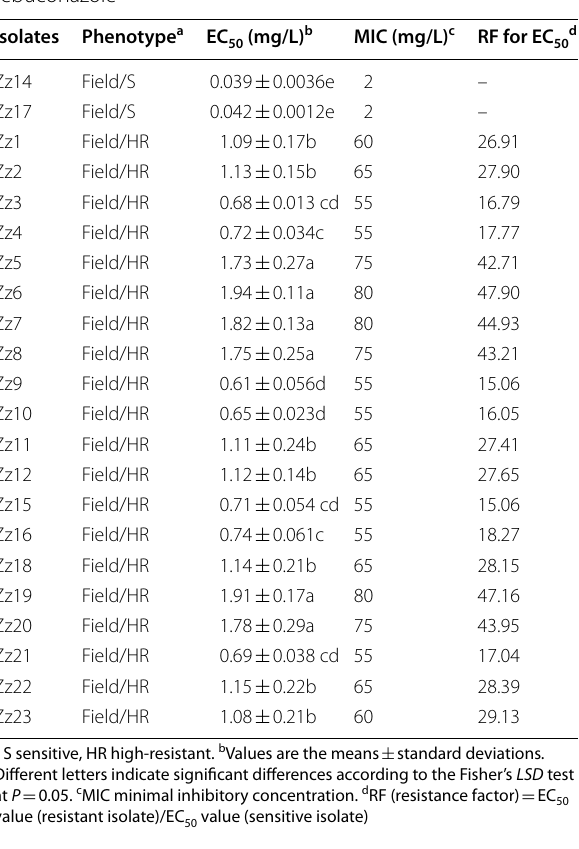
Table 1 Sensitivities of Colletotrichum isolates from chili to tebuconazole